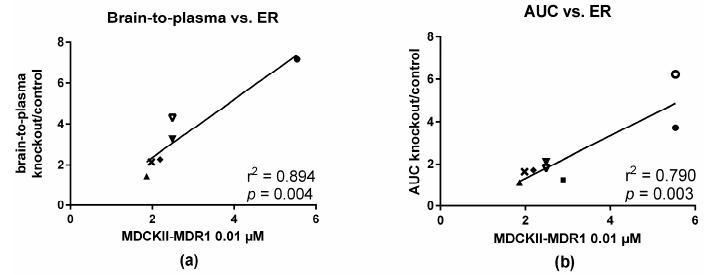
Figure 6. Correlation of in vitro ER values with ( a ) brain-to-plasma ratios and ( b ) AUC ratios between knockout and control mice. Brain-to-plasma ratios were calculated based on the biodistribution data 45 min p.i. using Mdr1a/b ( − / − ) Bcrp1 ( − / − ) knockout and control mice dosed with [ 11 C]verapamil ( ● ), [ 18 F]MC224 ( ▲ ), [ 18 F]MC198 ( ♦ ) and [ 18 F]KE64 ( × ). For [ 18 F]MC225 ( ▼ ), values from both Mdr1a/b ( − / − ) Bcrp1 ( − / − ) (closed symbols) and Mdr1a/b ( − / − ) (open symbols) mice were included. AUC ratios are calculated from whole brain SUV time-activity curves in the same strains as mentioned above,